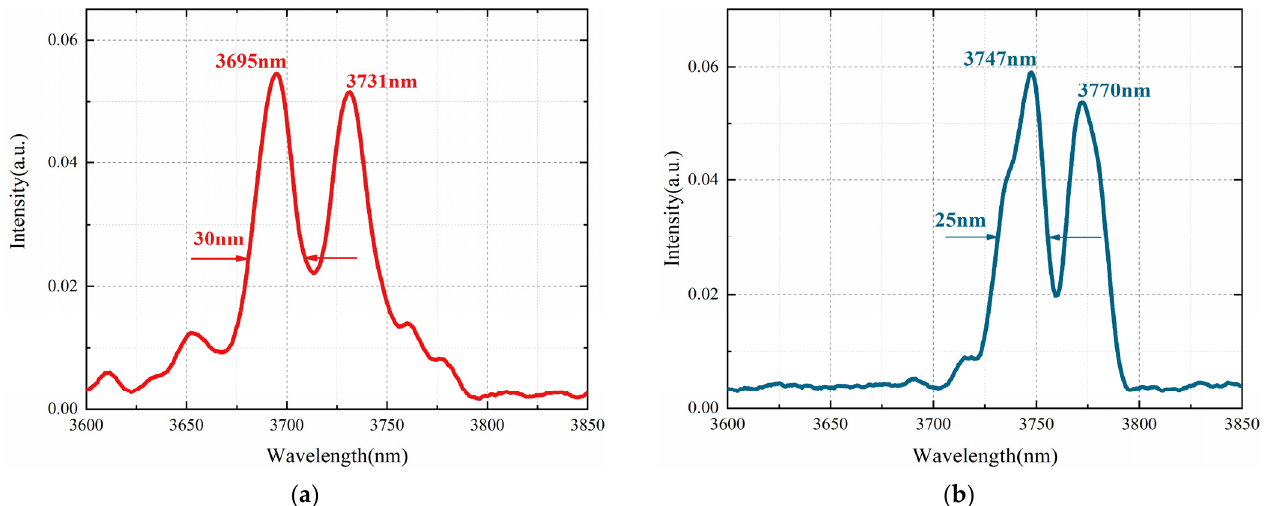
Figure 5. Intracavity DFG generates a double-peaked idler beam with the primary peak at ( a ) 3695 nm and ( b ) 3747